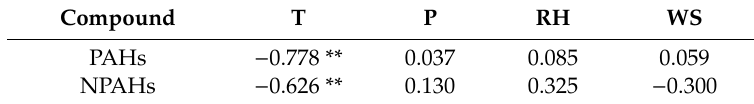
Table 1. Correlation coe ffi cients for the relationships of PAHs and NPAHs in PM 2.5 with meteorological data. Compound T P RH WS PAHs − 0.778 ** 0.037 0.085 0.059 NPAHs − 0.626 ** 0.130 0.325 −